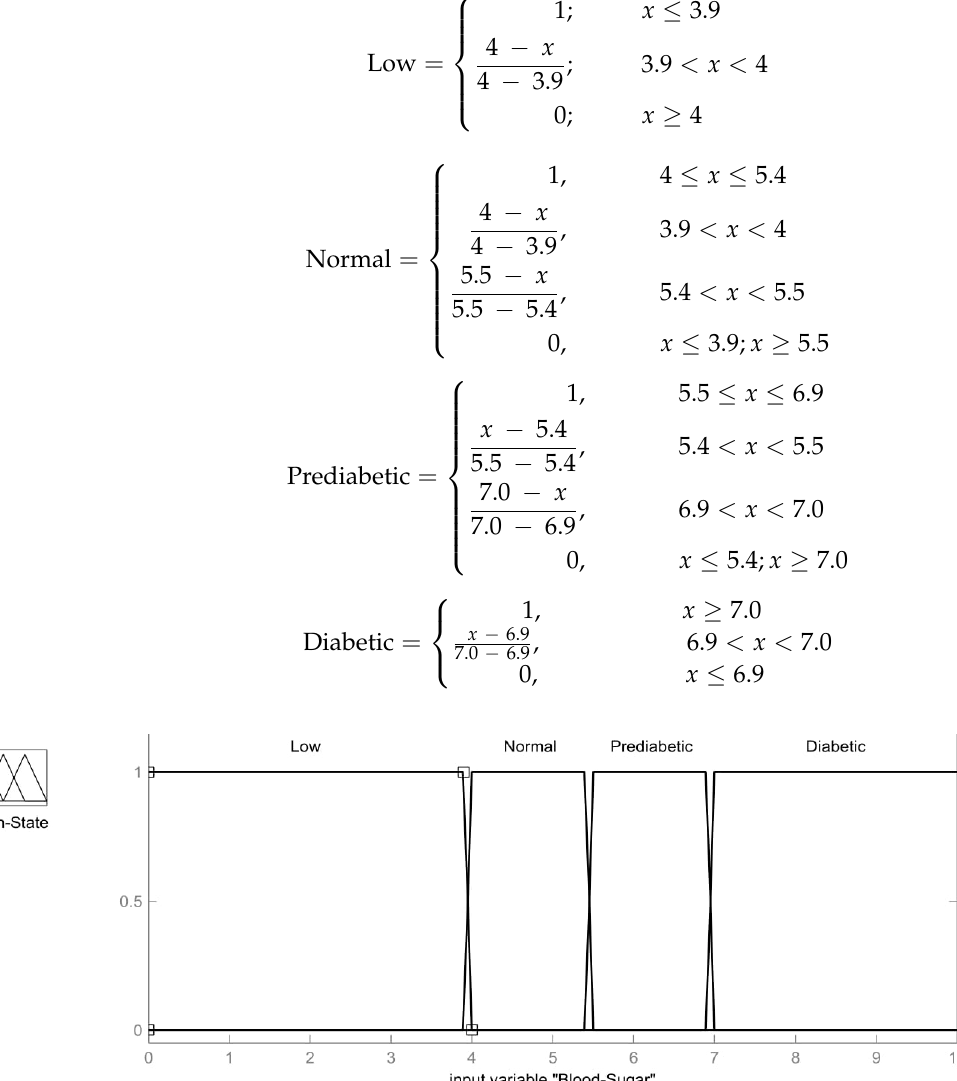
Table 1. Inputs for fuzzification. Blood Sugar Low, Normal, Prediabetic, Diabetic Heart Rate Bradycardia, Normal, Tachycardia